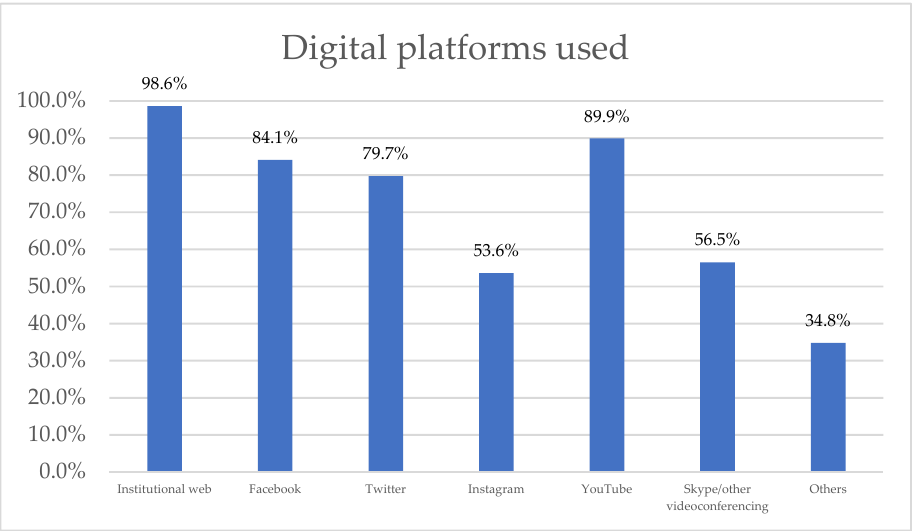
Figure 2. Digital platforms used by the diocese. Source: Authors.